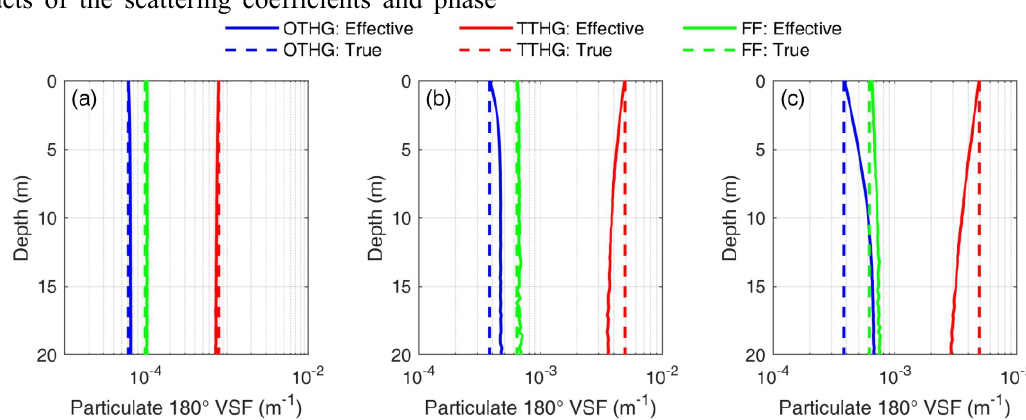
Fig. 4. Phase function effects on the effective particulate 180° VSF under (a) Case A (clear ocean, FOV of 50 mrad), (b) Case B (coastal ocean, FOV of 50 mrad) and (c) Case C (coastal ocean, FOV of 200